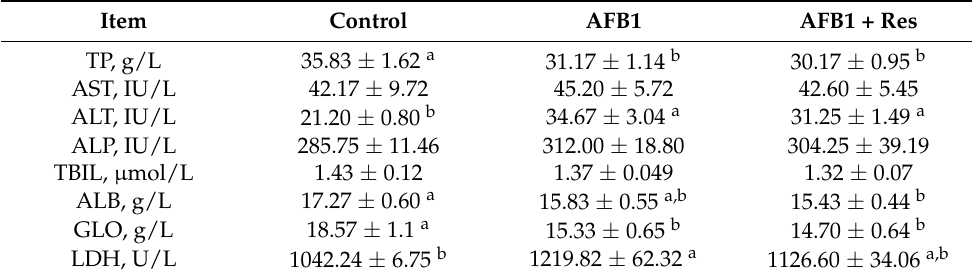
Table 3. Effects of Res on liver function of duck exposed to